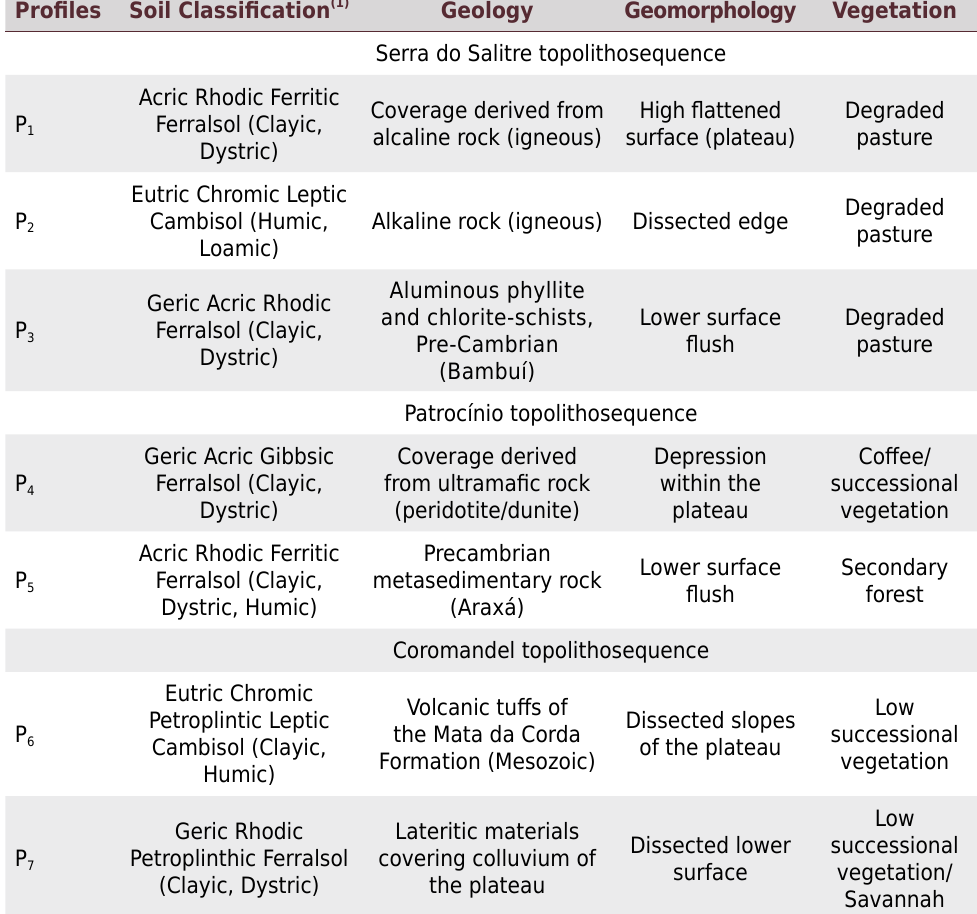
Table 1. Soil classification, geology, geomorphology, and vegetation of the three topolithosequences